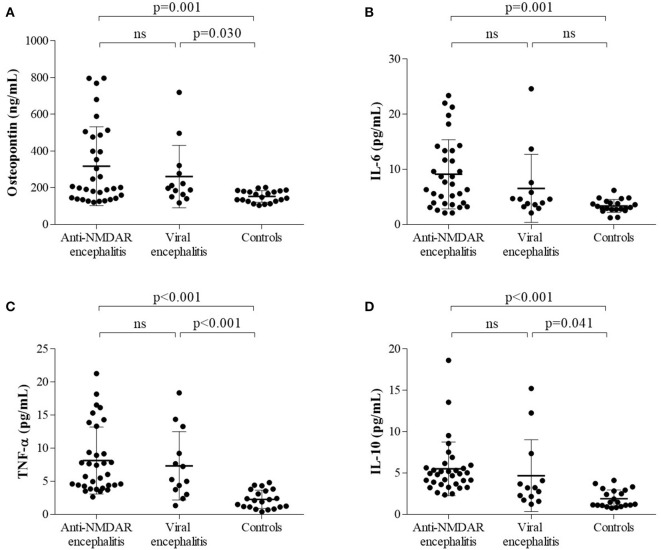
The levels of (A) cerebrospinal fluid osteopontin (CSF OPN), (B) interleukin (IL)-6, (C) tumor necrosis factor alpha (TNF-α), and (D) IL-10 in anti-N-methyl-d-aspartate receptor (anti-NMDAR) encephalitis patients and two control groups were shown. (A–D) Higher CSF levels of OPN, IL-6, TNF-α, and IL-10 were found in anti-NMDAR encephalitis patients than those in controls but not viral encephalitis patients.